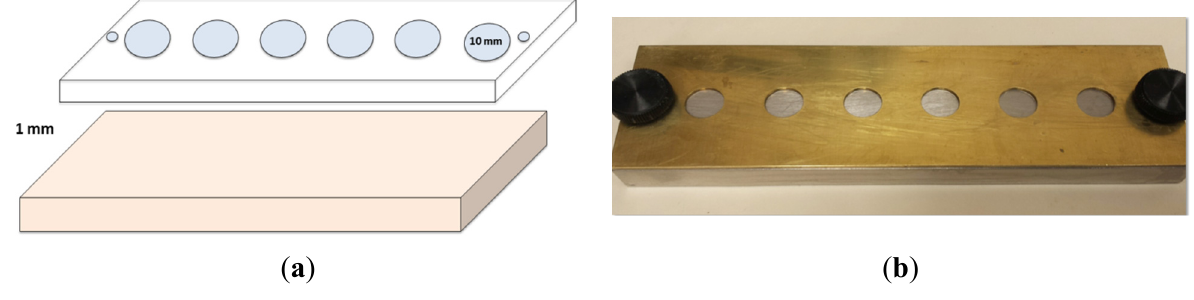
Figure 1. ( a ) Layout of the two parts of brass mold; ( b ) Brass mold